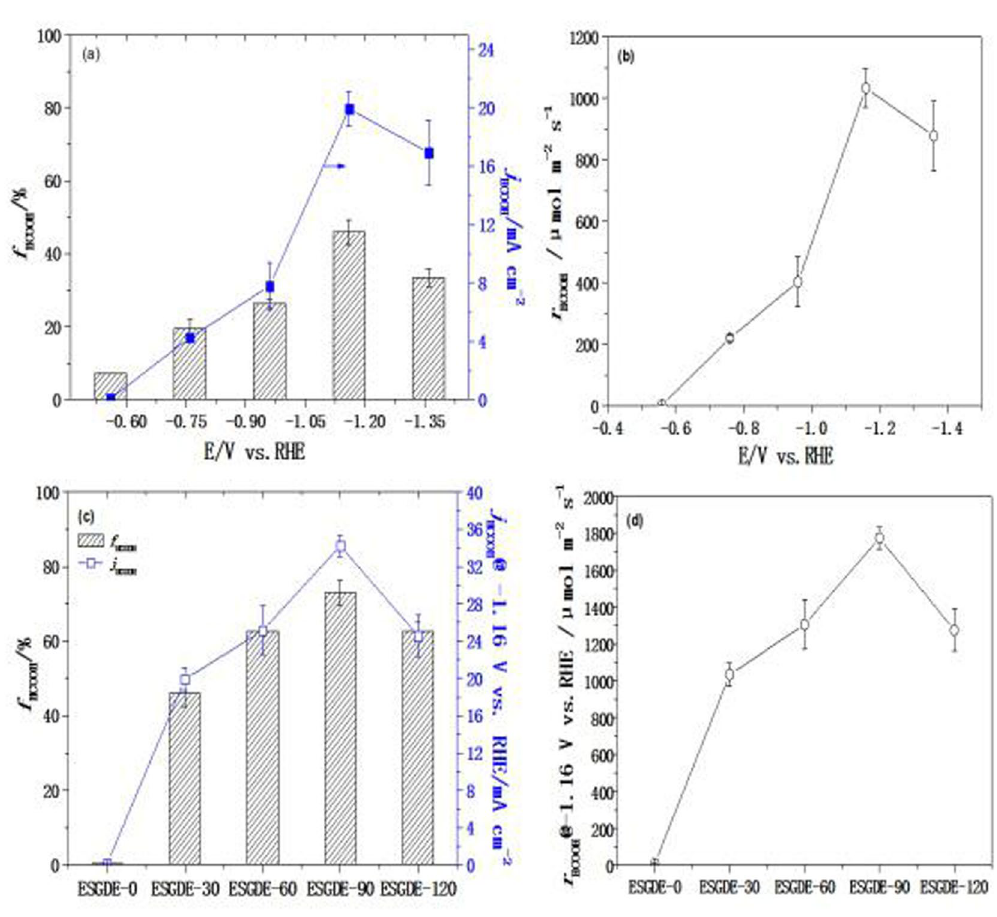
Figure 7. ( a , b ) Variations in the f HCOOH , j HCOOH and r HCOOH with electrolysis potential in 0.5 M CO 2 -saturated KHCO 3 solution (pH = 7.47) at the ESGDE-30. ( c , d ) ERCF tests results at -1.16 V vs. RHE in 0.5 M CO 2 - saturated KHCO 3 solution (pH = 7.47) at the ESGDEs with different electrodeposition time and ESGDE-0. Error bars based on three duplicate measurements for each